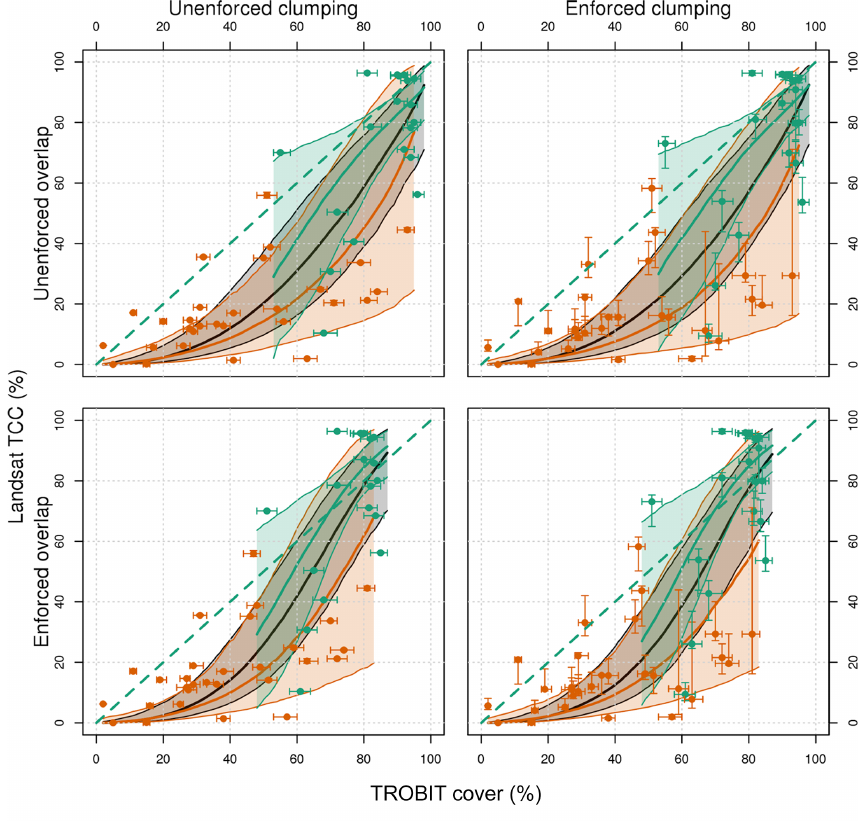
Figure 5. Landsat TCC percent tree cover versus percent tree cover from TROBIT field data, taking into account uncertainties associated with tree cover spatial distributions within a TCC pixel and/or field site. The four combinations are the following: (1) no overlap and no clumping, where tree canopies are randomly distributed within both the pixel and site; (2) no overlap and maximum clumping, where tree canopies are clustered in one area of the pixel and randomly distributed throughout the field site; (3) with overlap and no clumping, where tree canopies are randomly distributed within the pixel but overlap substantially within the field site; and (4) with overlap and maximum clumping, where tree canopies are clustered to one side within the pixel and overlap substantially within the site. The bolded dashed line in black shows the 1:1 relationship. The solid lines represent the median of the respective regressions (green for forest, orange for savanna, and black for forest and savanna combined), and the thin lines represent the 5% and 95% confidence interval of their respective regression lines. The vertical error bars represent uncertainty introduced by clumping; the horizontal error bars represent the uncertainty introduced by